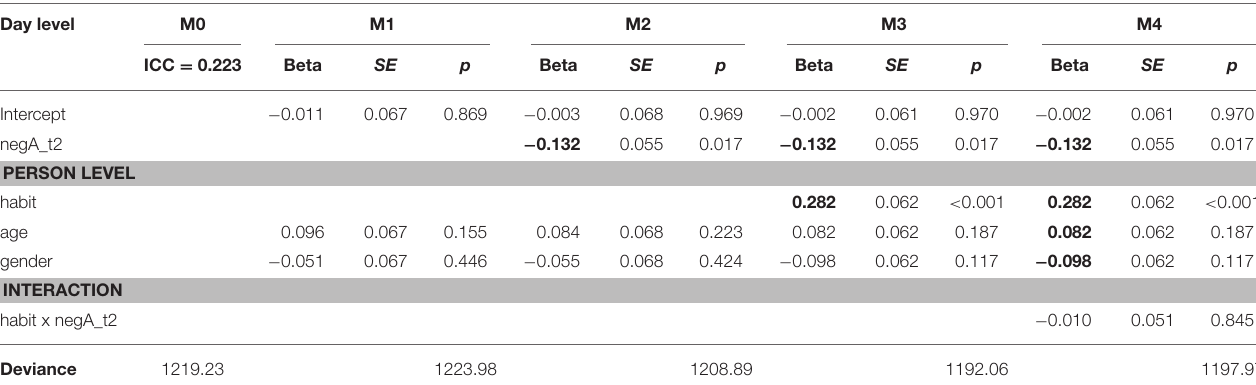
TABLE 4 | Model 2.2: Prediction of self-reported after work MVPA by negative affect and habit strength. Day